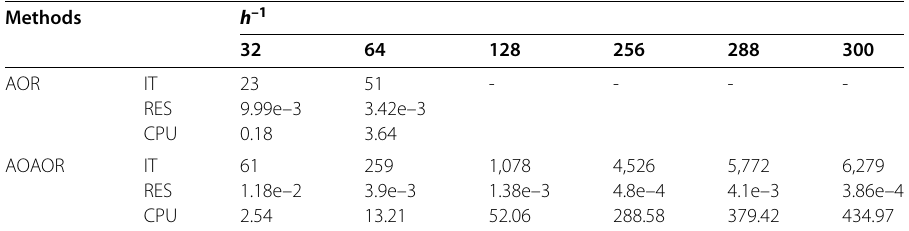
Table 4 Numerical results when ξ = 30.0, ζ = 0.0, σ = 10.0 ( ε = h 2 ) Methods